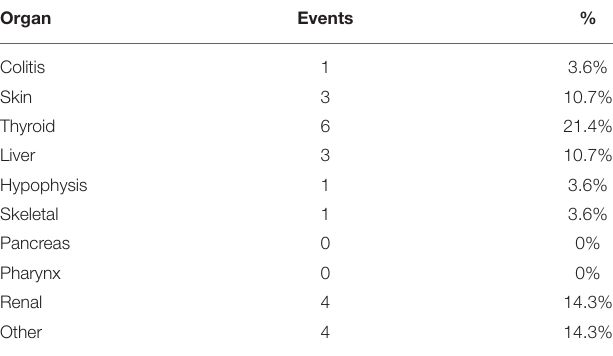
TABLE 3 | Summary of immune-related adverse events.